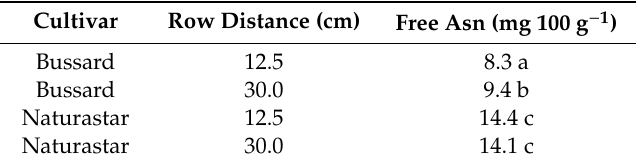
Table 5. Level of free Asn (mg 100 g − 1 ) across years influenced by cultivar and row distance. Di ff erent letters next to free Asn amount refer to significant di ff